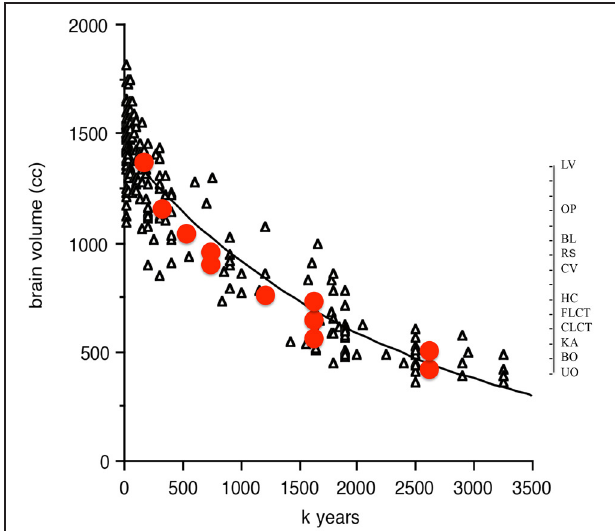
FIGURE 4 | Ordinal tool complexity scale (red circles) from Stout (2011) plotted over absolute brain size (in cc) as a function of time from 3.2 million to 10,000 years BP. Scale on right indicates ordinal increases in tool complexity. Abbreviations refer to categories in Stout (2011) Figure 2 . UO, unifacial Oldowan; BO, bifacial Oldowan; KA, karari; CLCT, core LCT; FLCT, flake LCT; HC, hierarchical centripetal; CV, cleaver variants; RS, refined shaping; BL, blades; OP, other predetermined; LV, Levallois variants.